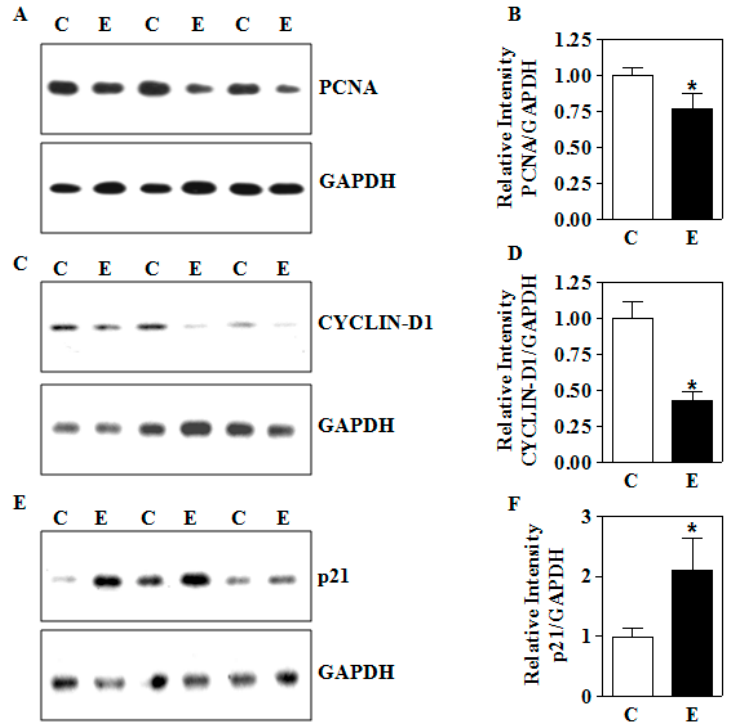
Figure 7. Effects of intrauterine IEV exposure on the protein expression of growth modulators in the placenta. The IEV exposure was performed as in Figure 1. ( A ) Representative immunoblots and ( B ) densitometric summary for PCNA in the placenta; ( C ) CYCLIN-D1 protein expression by immunoblotting and ( D ) its densitometric quantification in the placental tissue; ( E ) determination of placental p21 protein expression and ( F ) its quantification summary. For each measurement, a total of 12 placentas with 4 each from 3 different litters were used. Values represent the mean ± SEM. * p < 0.05 was considered significant versus ethanol.